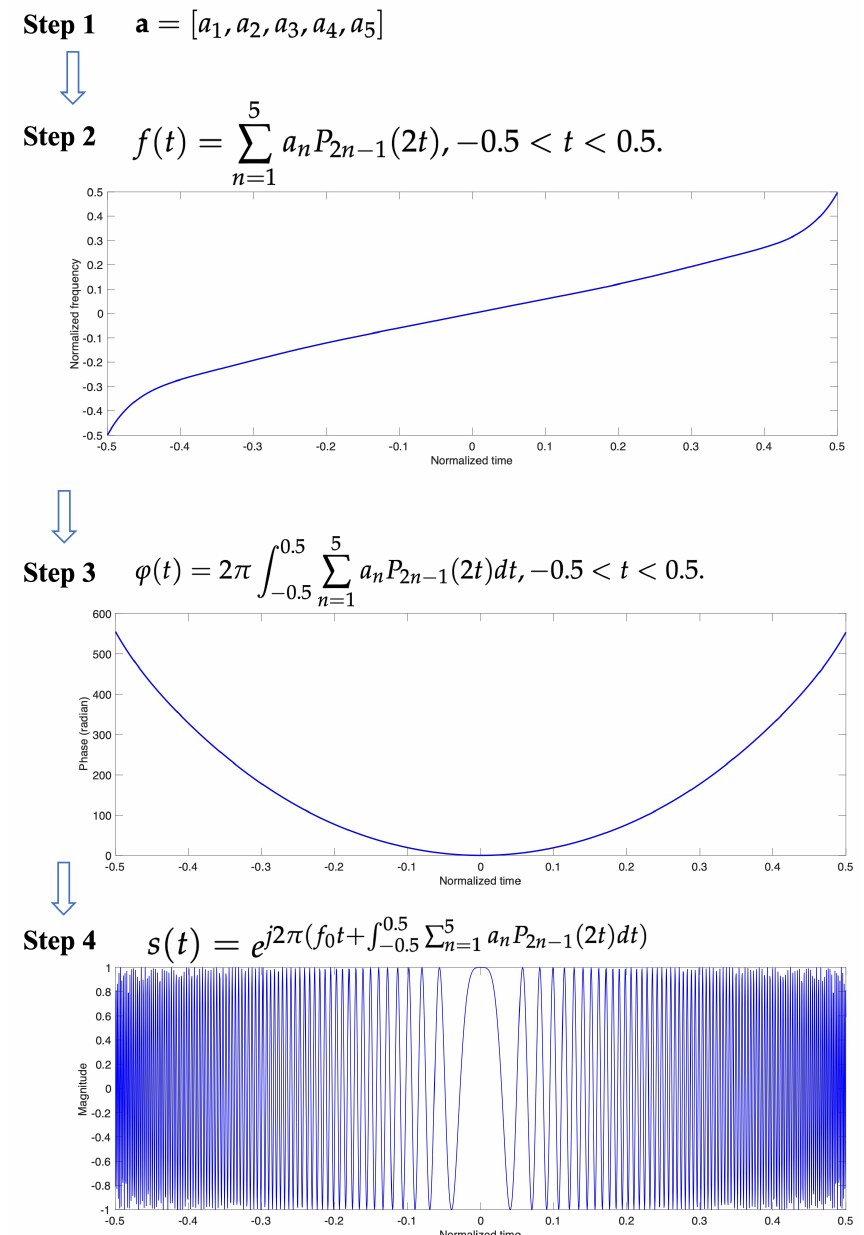
Figure 2. Procedures for modelling NLFM